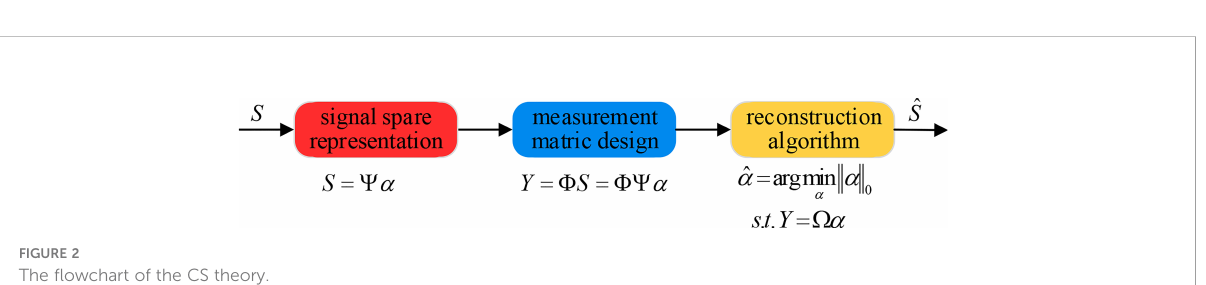
FIGURE 2 The fl owchart of the CS theory.